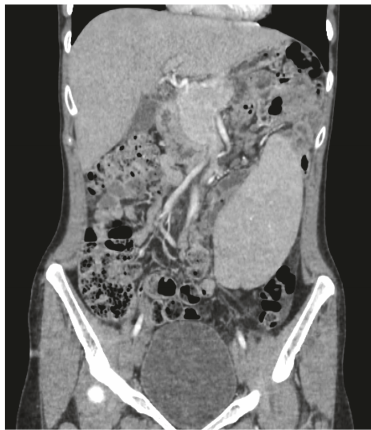
Figure 2: CT of the abdomen demonstrating spleen in the inferior quadrant of the